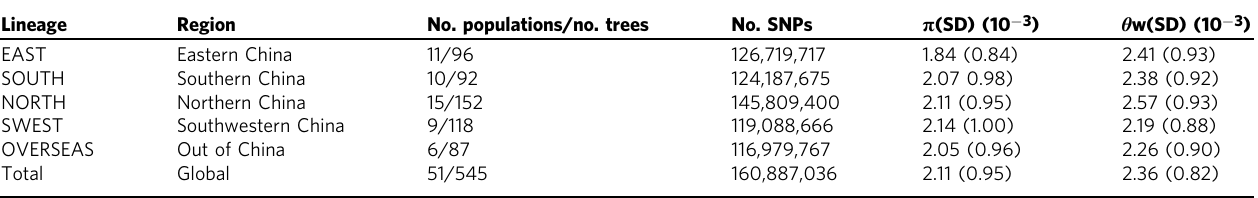
π average number of pairwise nucleotide differences per site, θ W Watterson ’ s estimator of θ per base pair a All samples were grouped based on geographical distributions